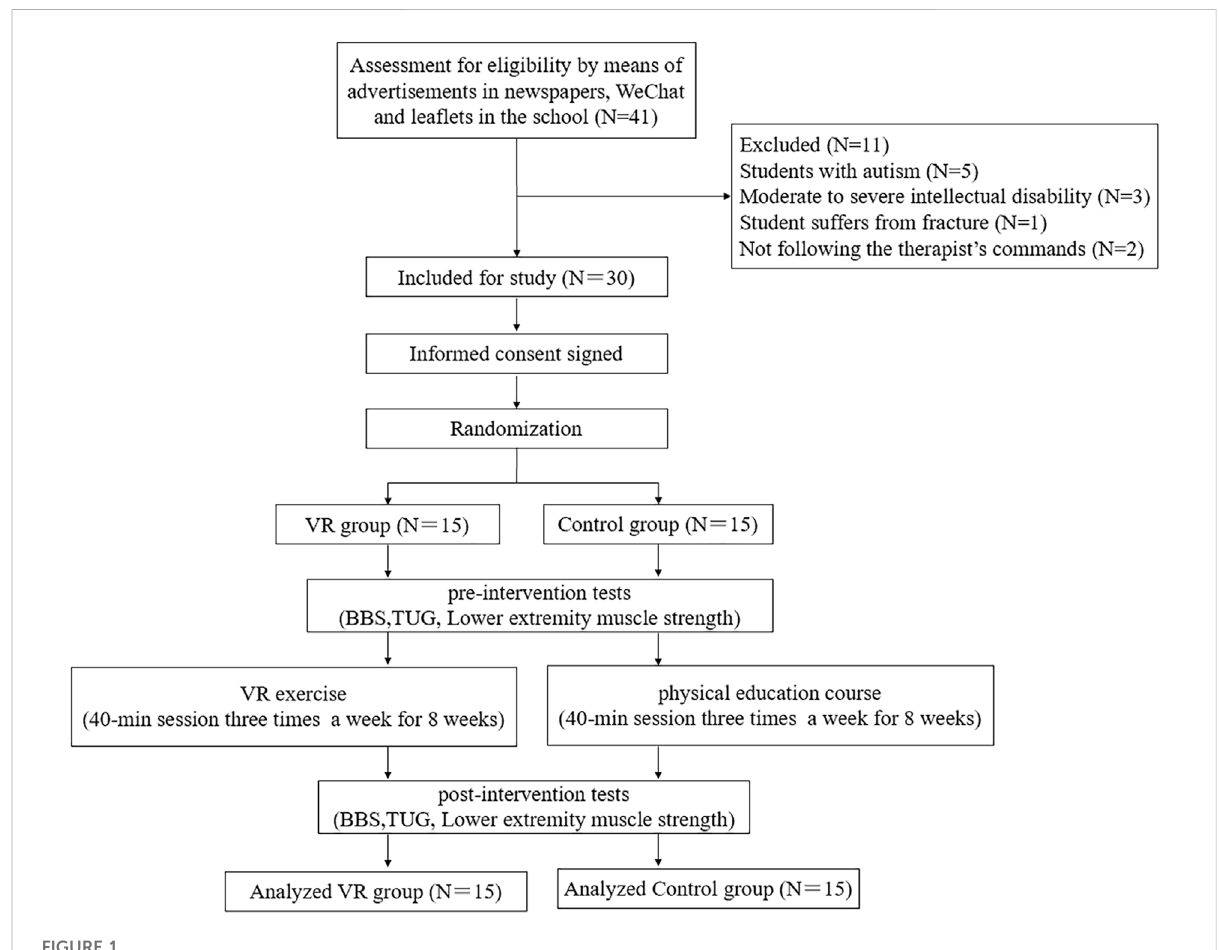
FIGURE 1 Flow diagram for randomized controlled